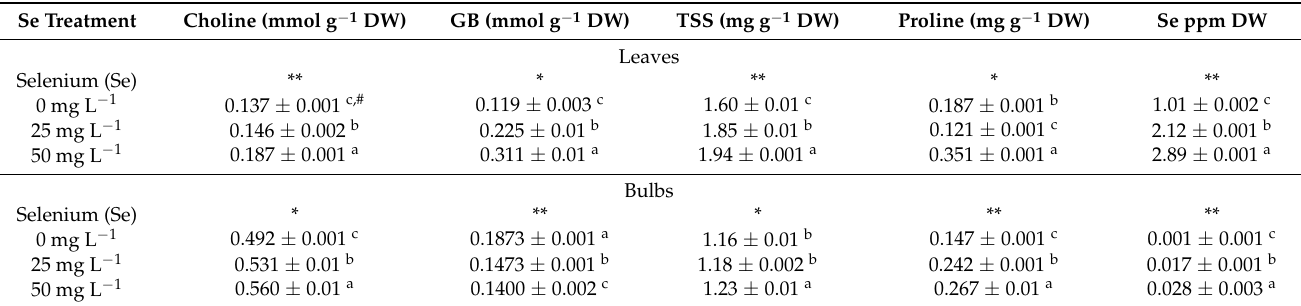
Table 6. Effects of foliar applications with selenium (Se) on the leaf and bulb contents of osmoprotectants: choline, glycine betaine (GB), total soluble sugars (TSS), and proline of onion under saline soil (EC = 5.2 dS m − 1 ) conditions. Se